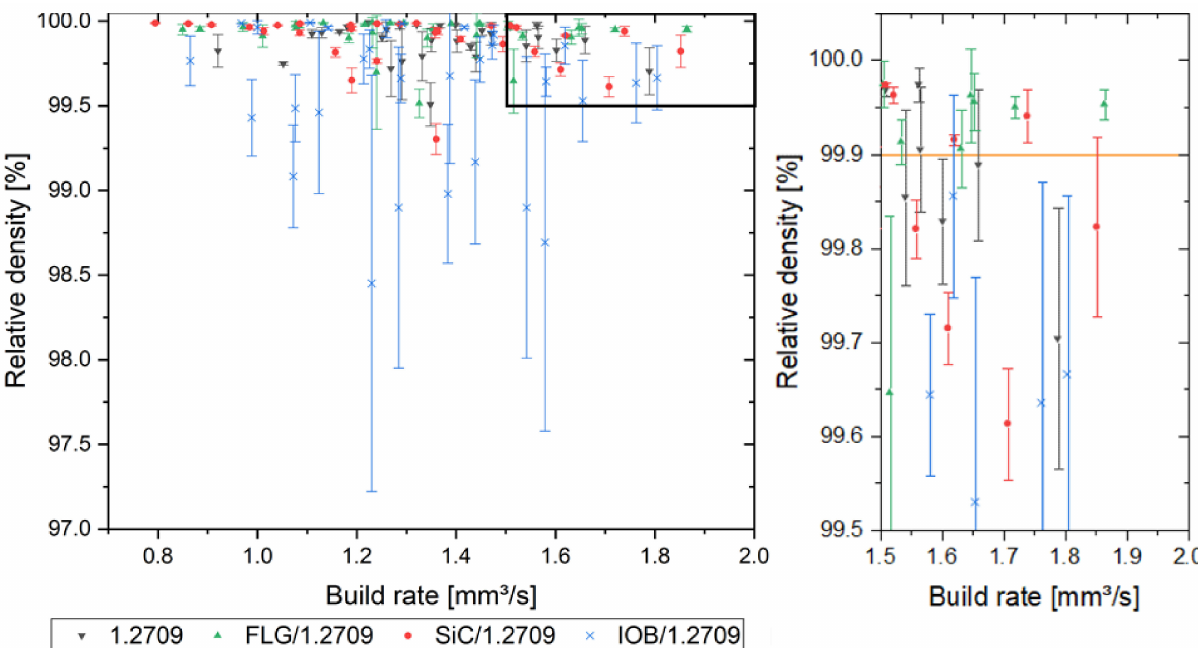
Figure 11. Relative density with respect to build rate of 1.2709 and its nanoparticle coatings. Overview of all evaluated specimens (left diagram), black framed area illustrated in right